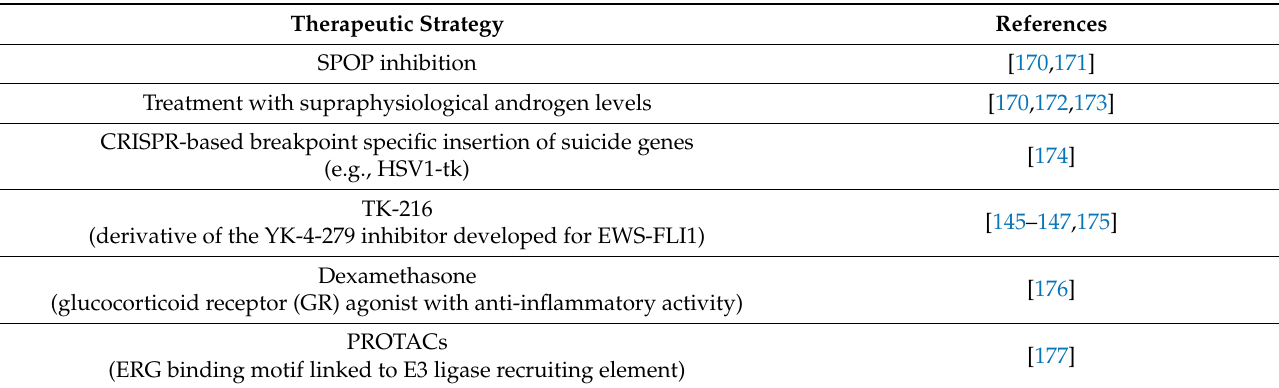
Table 1. Future strategies to target ERG-positive